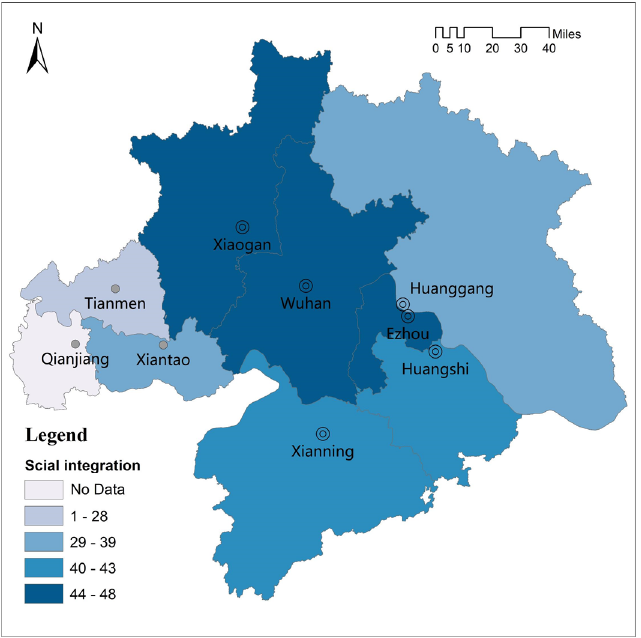
Figure 8. Spatial distribution of migrants’ social integration in the Wuhan urban agglomeration.